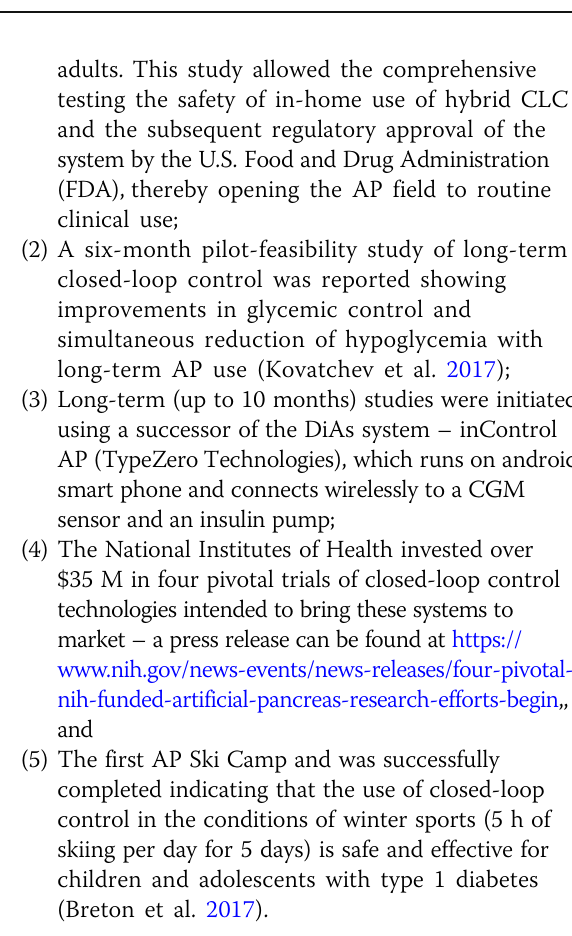
Fig. 3 The two principal configurations of a wearable artificial pancreas: embedded, with a control algorithm running on board of an insulin pump, and mobile, using consumer electronics as a computational and communication hub. Both configurations have their advantages and